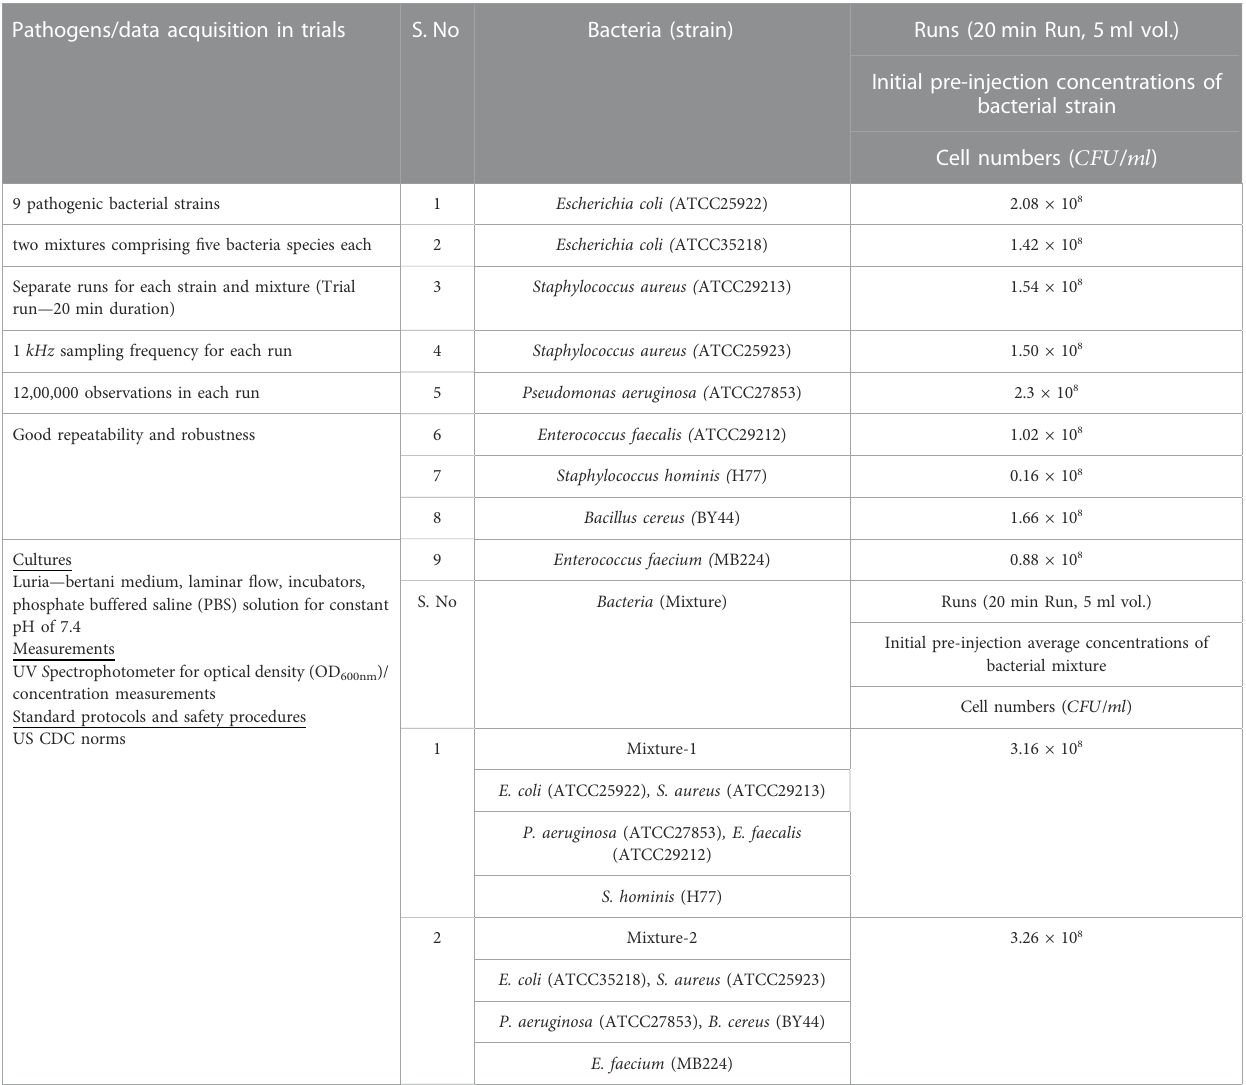
TABLE 1 Photonic system AUM trials with injection details of the samples investigated (bacterial strains and mixtures of bacteria) and their pre-injection concentrations before injection. Cell culture particulars, protocols, and procedures adopted for their classi fi cations using gold standards along with durations of eachrun are highlighted. For trials withIndividualmicrobe strains as wellas withmixtures,concentrationsintroduced into the anaerobic chamber increased with time during each run. During the various Runs with different bacterial strains, the minimum concentrations of bacterial strains injected, were < 10 CFU, while the maximum concentrations ranged from 1.6 × 10 7 CFU to 2.3 × 10 8 CFU . During the trial runs with mixtures of fi ve bacterial species, the minimum concentrations of bacterial species injected were < 10 CFU, while the maximum concentrations ranged from 0.1 × 10 8 CFU to 3.2 × 10 8 CFU in the mixtures. Pathogens/data acquisition in